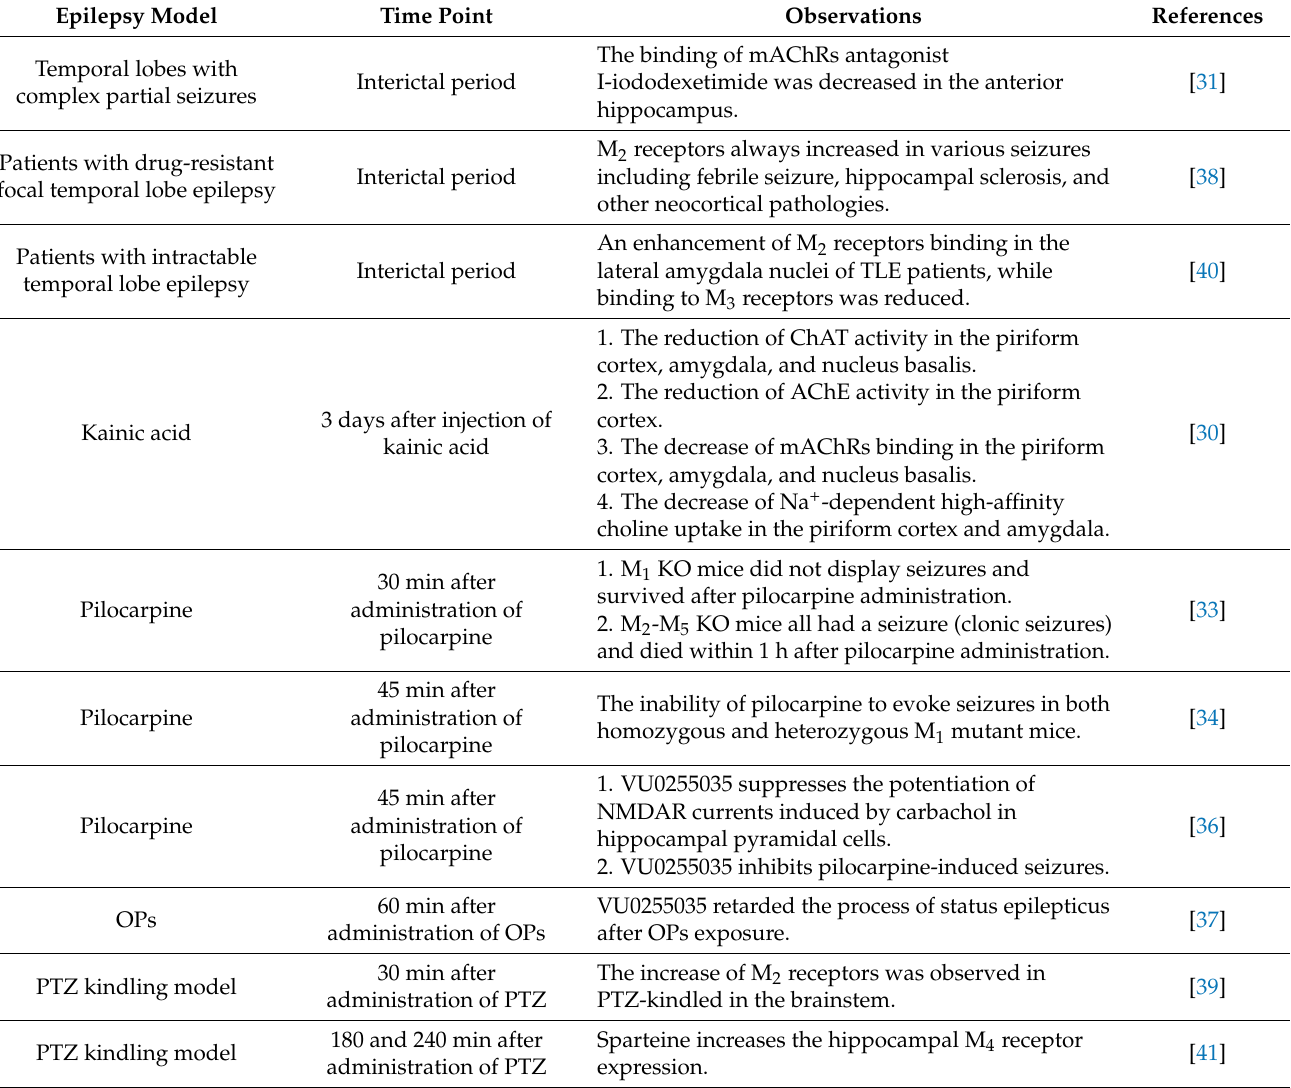
Table 1. Summaries of findings reporting the role of mAChRs in